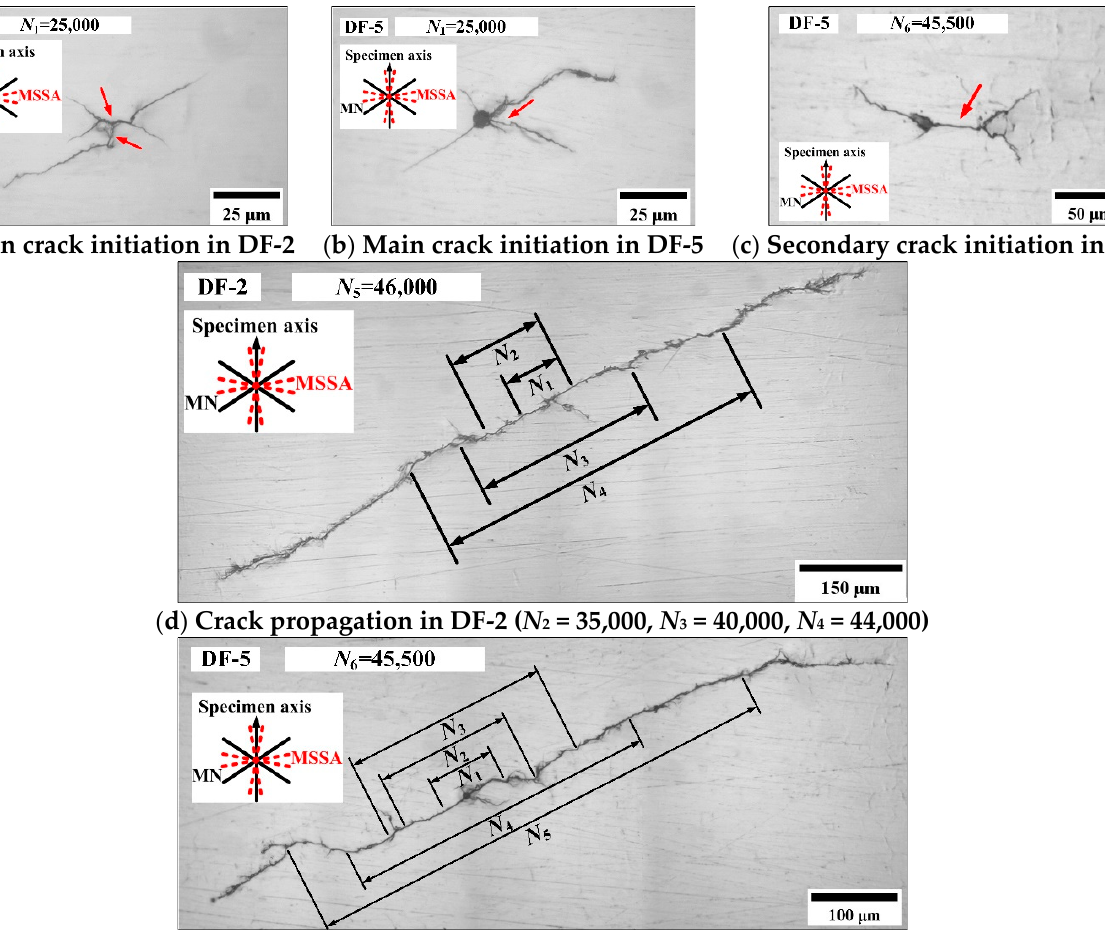
Figure 10. Crack morphologies in specimens DF-2 and DF-5.